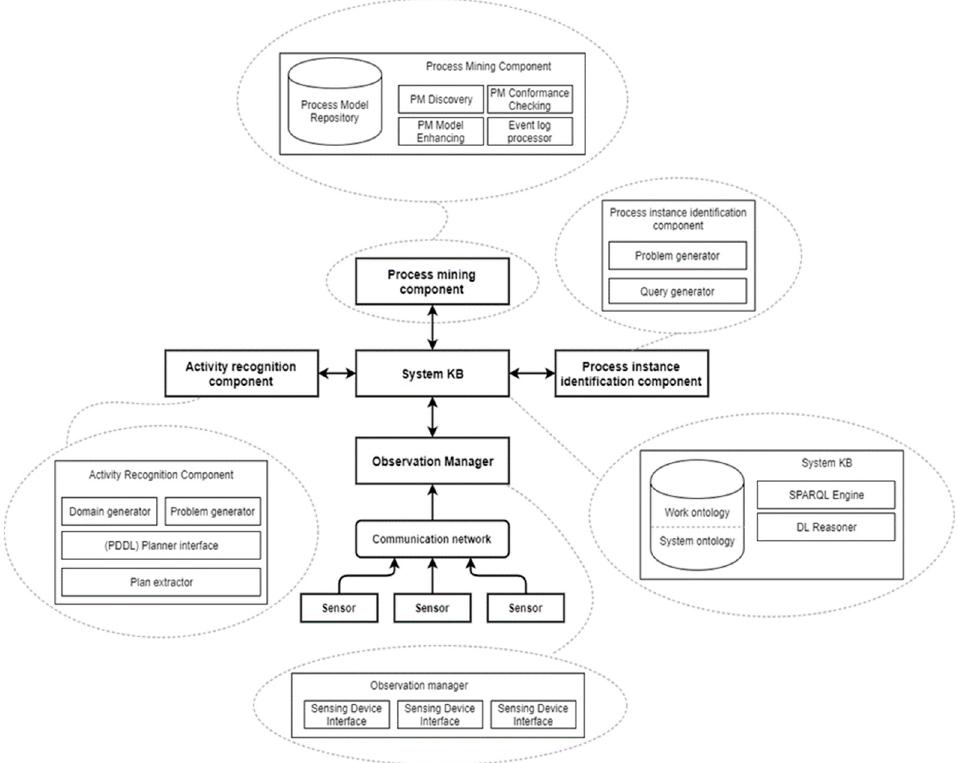
Figure 5. Process identification system model.